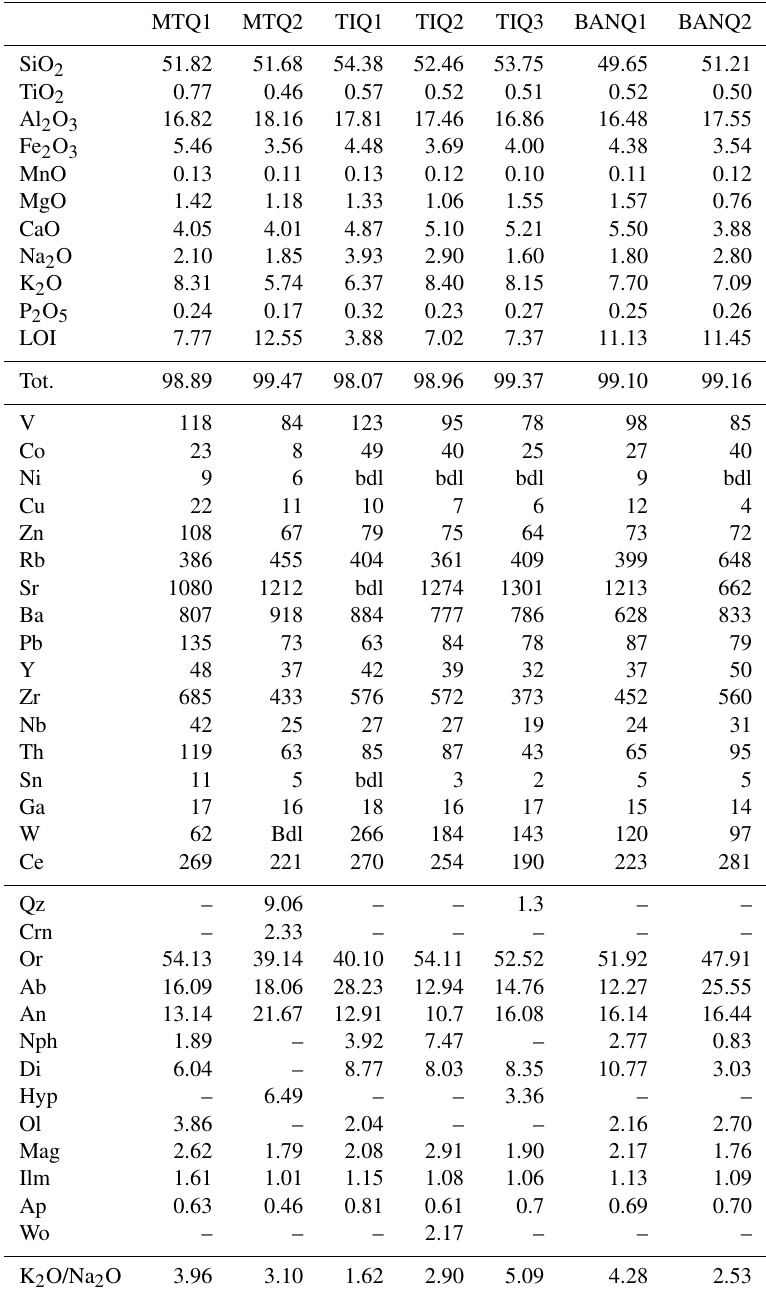
Table 1. Bulk chemical composition of TRS rock samples (wt% for major elements and parts per million for minor elements). MTQ1-2: Monte del Tempio quarry, location Sutri; TIQ1-3: Tufitalia quarry, location Civita Castellana; BANQ1-2: La Bannita quarry, location Castel S. Elia. LOI: loss on ignition. bdl: Below detection limit. CIPW values are reported for graphical representation. Mineral abbreviations as reported in Whitney and Evans